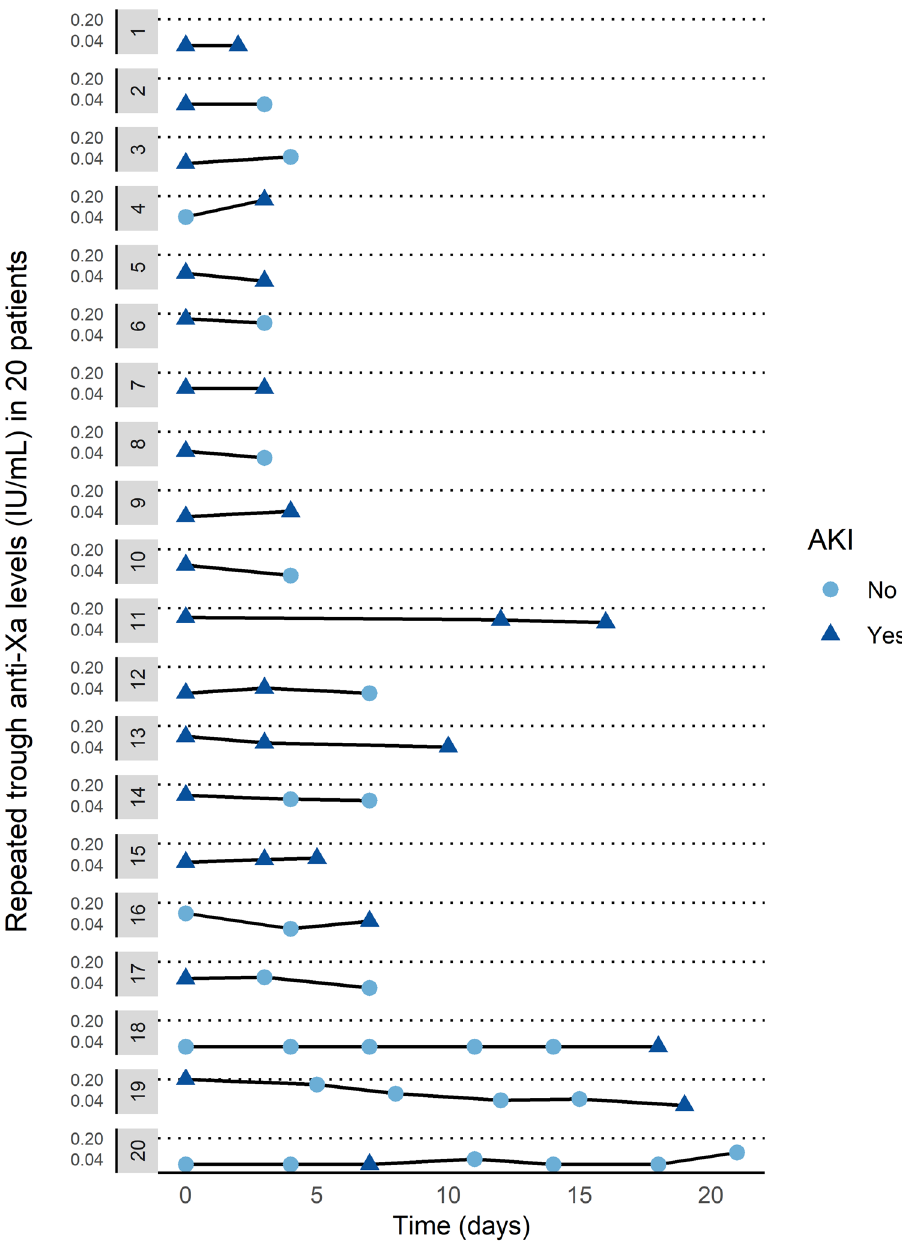
either during an episode of AKI (triangle) or no AKI (circle). The number of measurements for each patient varied from 2 to 7. The horizontal dotted lines indicate the cut-off point for our definition of bioaccumulation (> 0.20 IU/ml). AKI: acute kidney